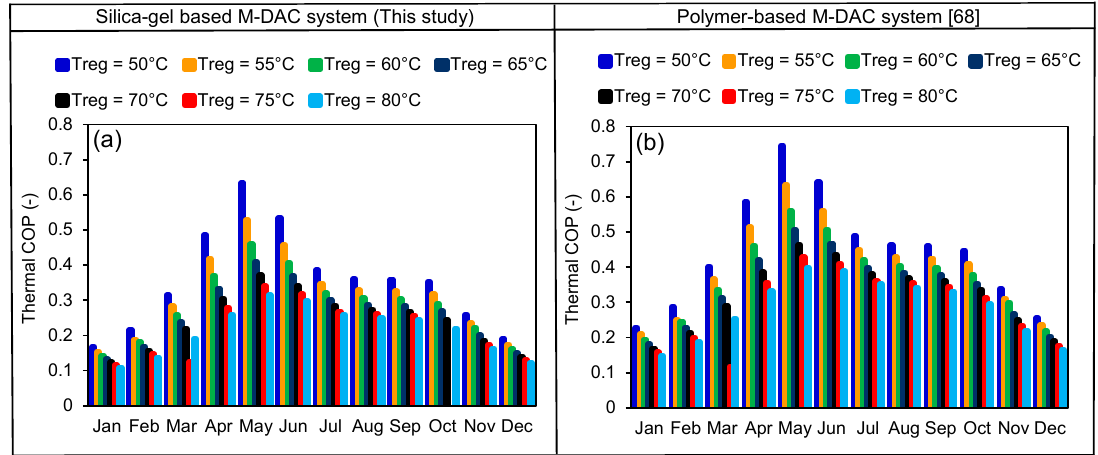
Figure A4. Thermal coefficient of performance of ( a ) silica-gel-based M-DAC system and ( b ) polymer-based M-DAC system at different regeneration temperatures.